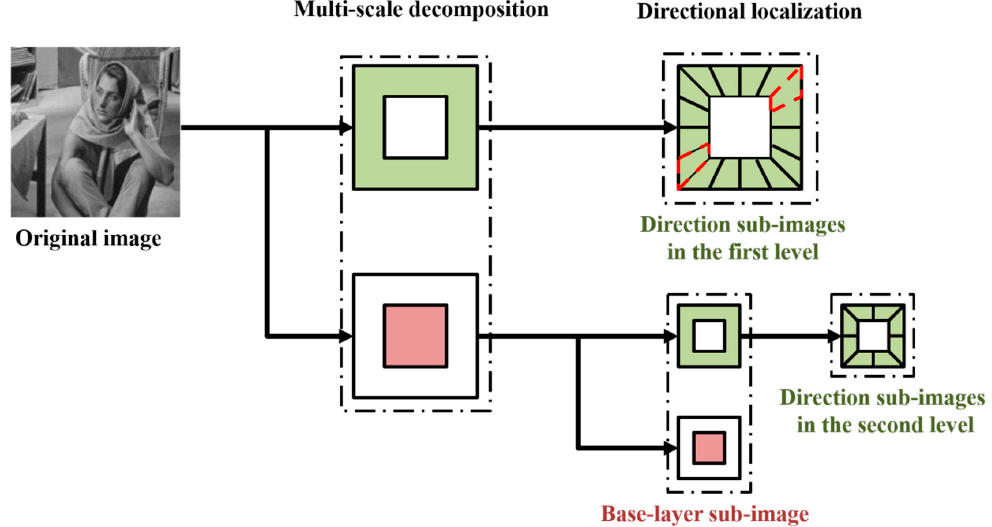
Figure 2. Image decomposition framework of the proposed method.